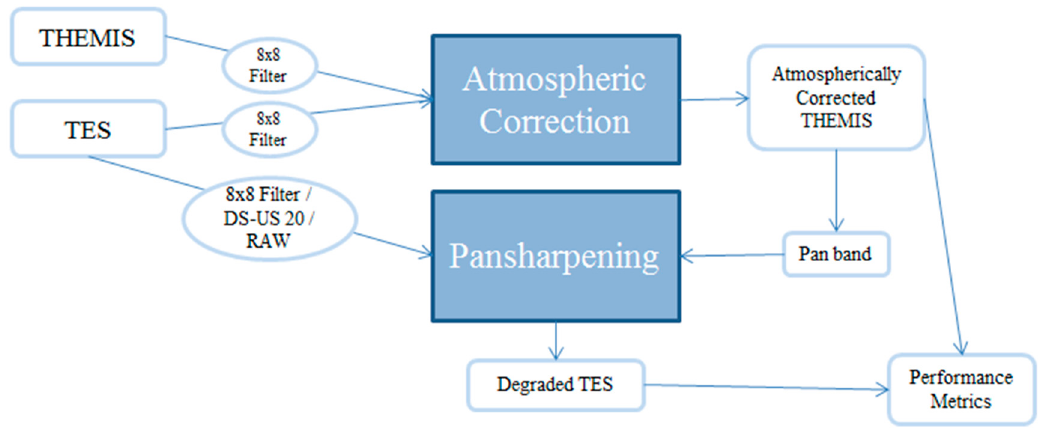
Figure 17. Diagram of THEMIS/TES fusion process.